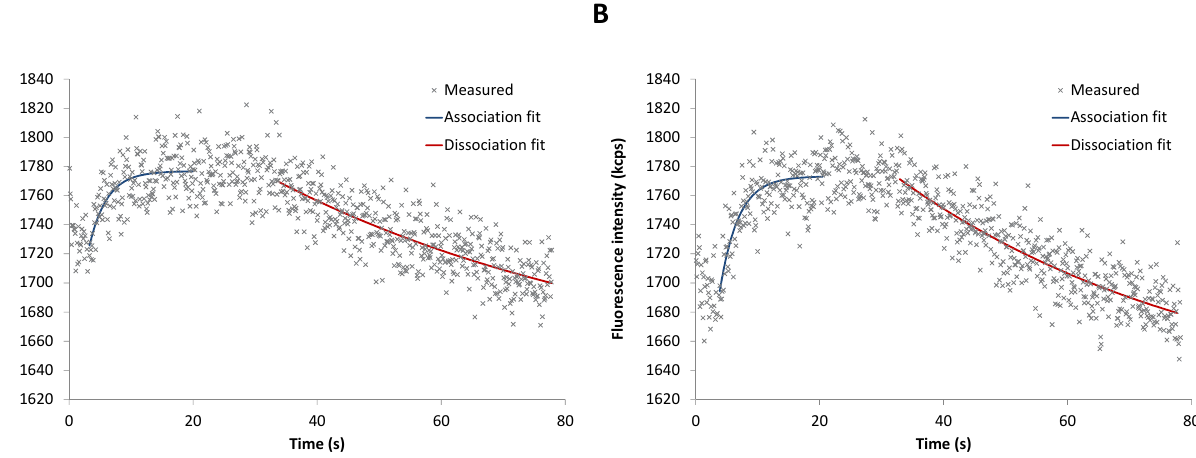
Figure 3. Fluorescence intensity versus time for the binding of GTP γ S (20 nM) to hTGase 2-dsDNA lever (static mode) obtained by non-directed ( A ) or His-tag-directed ( B ) labeling of hTGase 2 to ssDNA. Table 1. Rate constants for binding of GTP γ S to hTGase 2 .